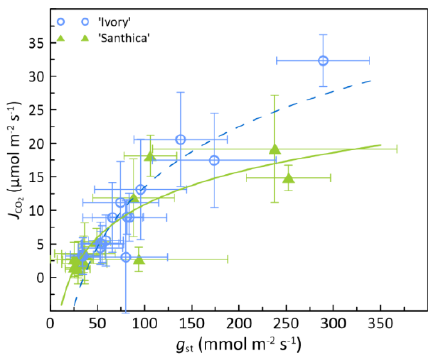
Figure 5. Plot of net CO 2 exchange rates ( J CO2 ) over stomatal conductance for water vapor transfer ( g st ) obtained during the course of the growing season on plants of ‘Ivory’ and of ‘Santhica 27’. The lines indicate the respective polynomial fits applied to the entire data sets.